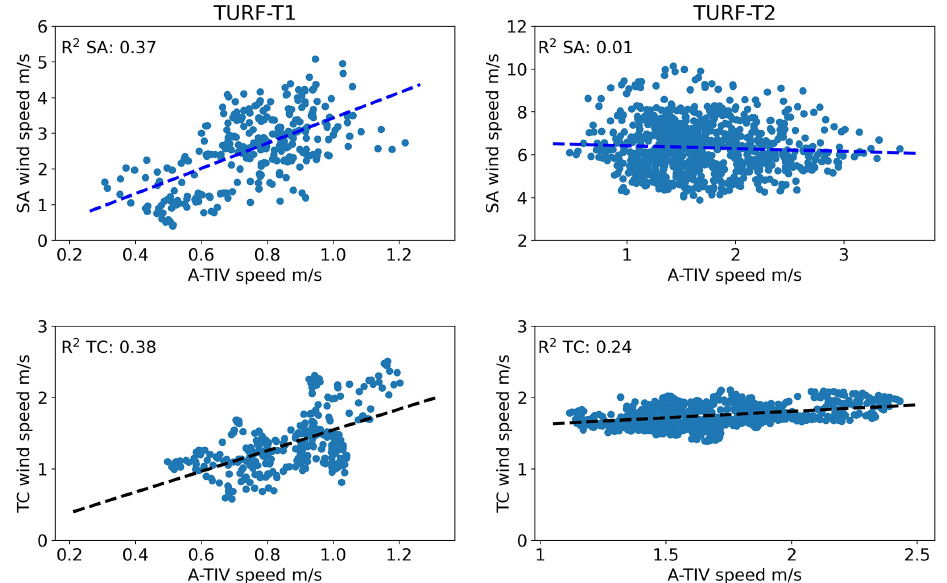
Figure 11. A-TIV speed relationship with other measurement methods – TURF-T1 and TURF-T2 relationship of wind speeds measured by the sonic anemometer and the lag correlation of the TC array with the A-TIV speed. It is evident that TURF-T1 shows higher R 2 values than TURF-T2. A weak relationship between the sonic anemometer and the A-TIV speed in TURF-T2 is evident.